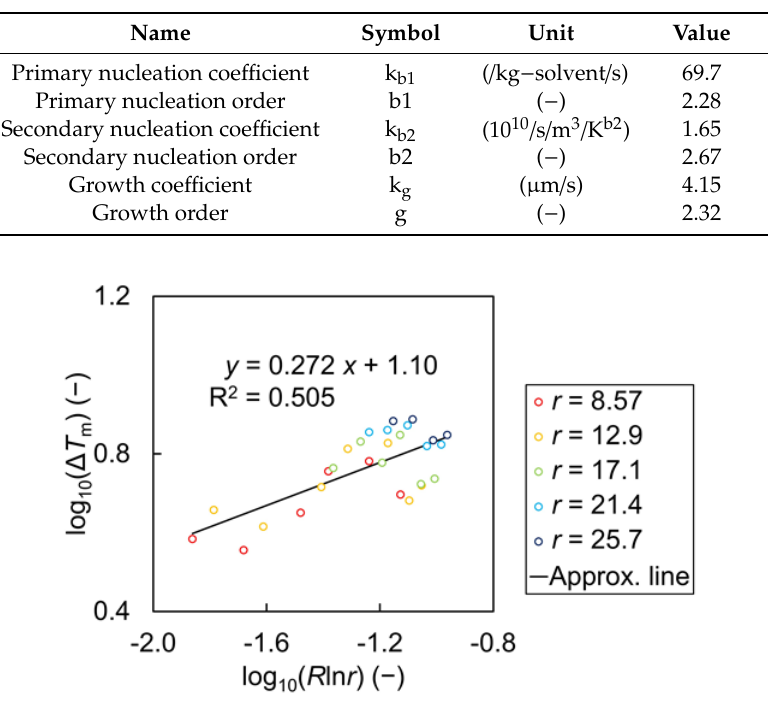
Table 5. Estimated kinetic parameters of the Arg crystallization.